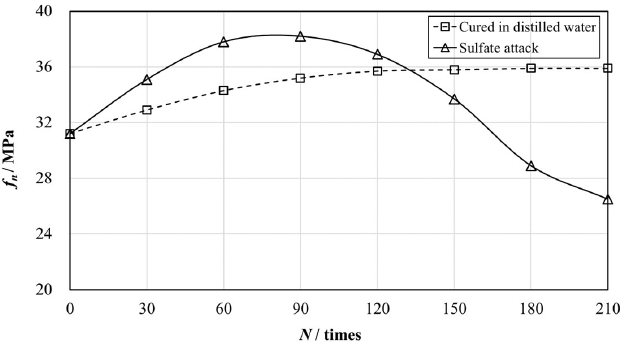
Figure 12. The evolution of the compressive strength of structural EPS concretes of group B and C with different numbers of W-D cycles ( N ).